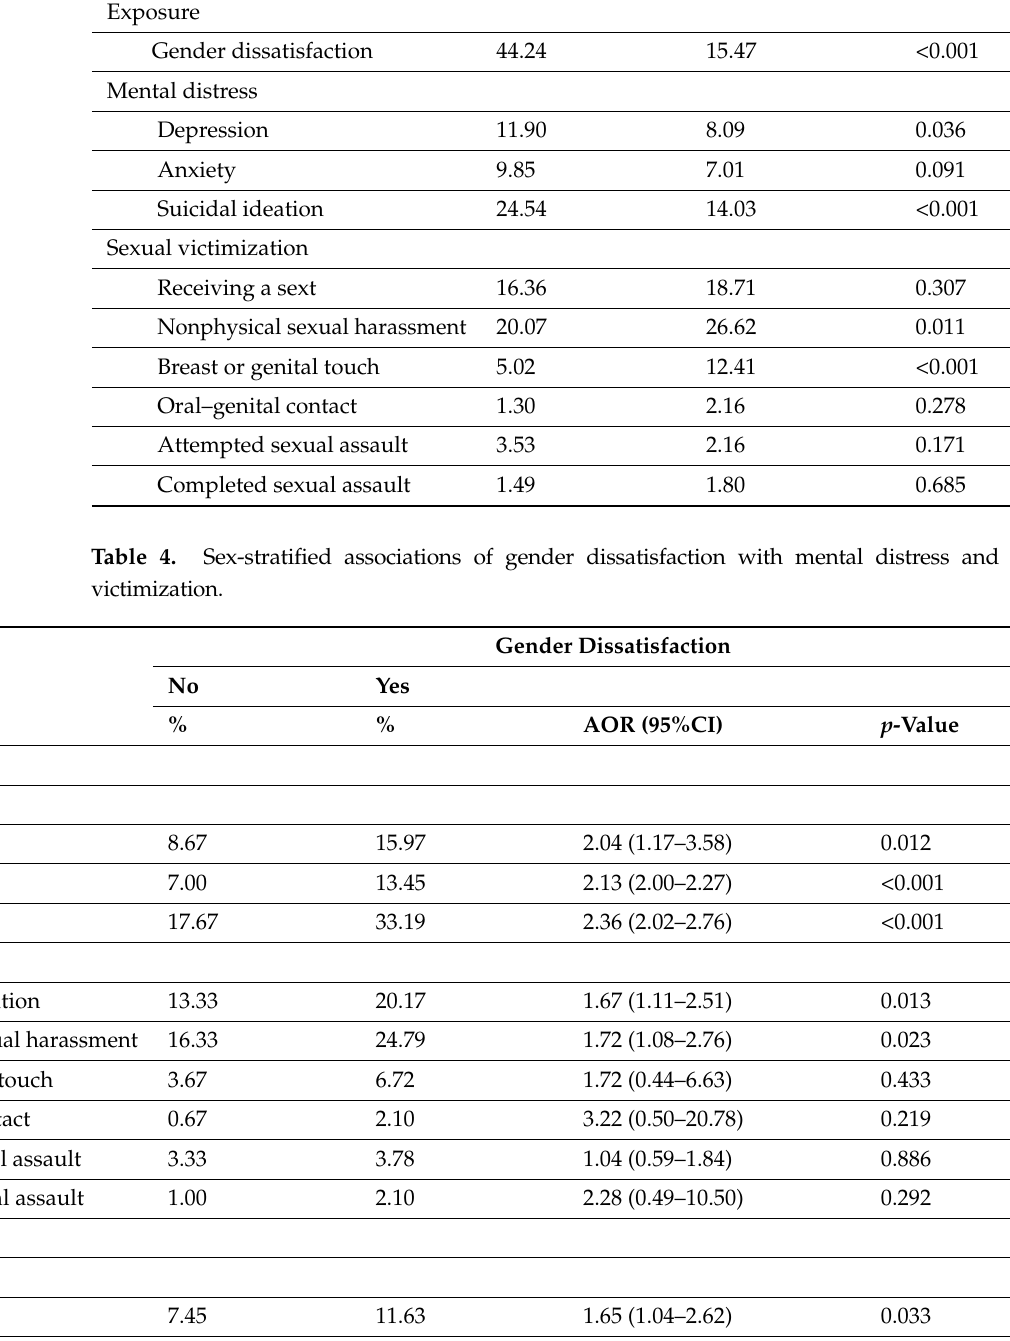
Variable of Interest